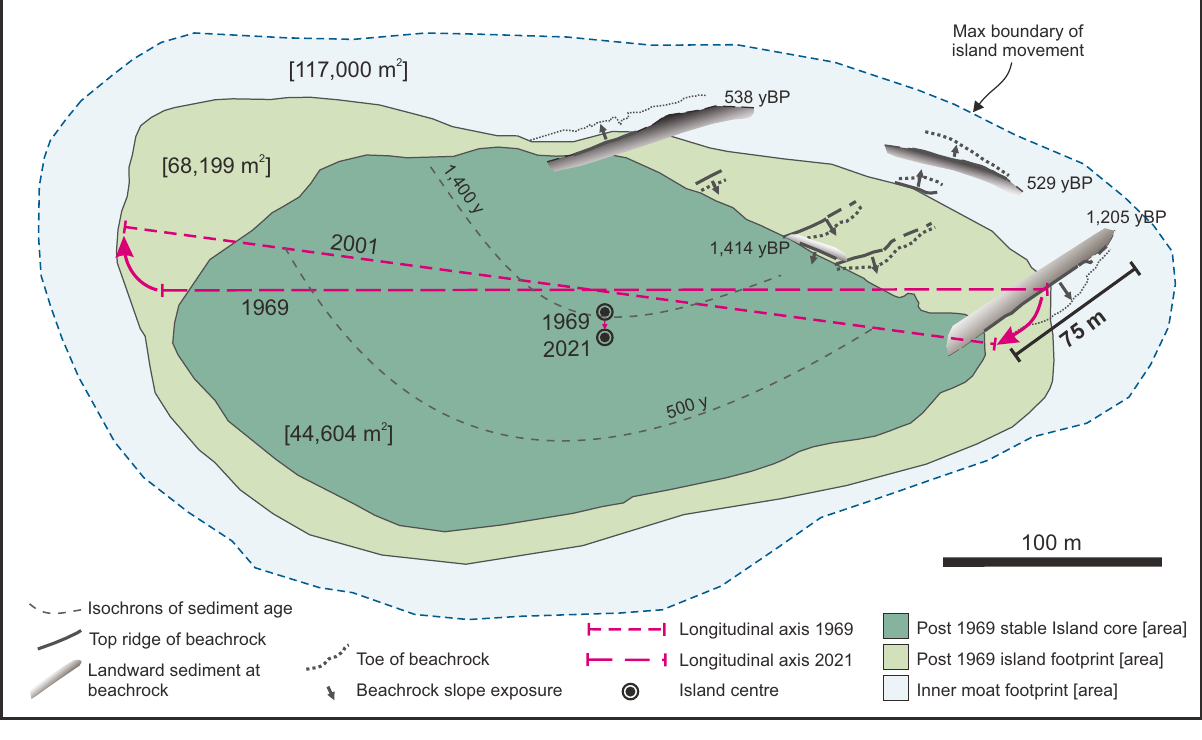
Fig. 5 | Summary island change indicators atKandahalagalaa, Huvadhooatoll, Maldives, based on multi-temporal indicators and showing boundaries of large-scale movement ofthe island sinceformation~1500 yearsago. Isochrons